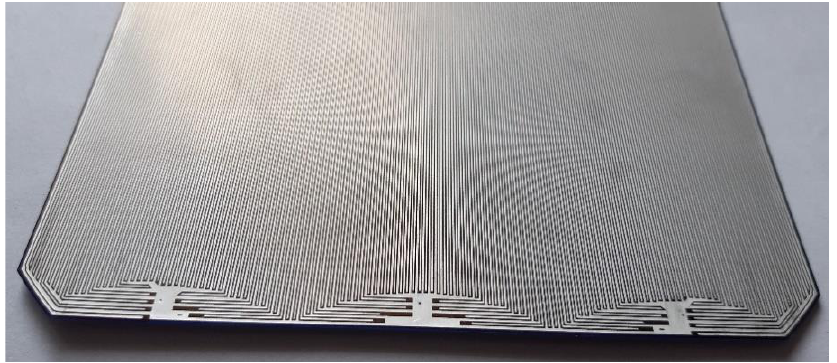
Figure 7. Rear surface of Maxeon Ne3 with visible connectors in the lower part. When analyzing the structure of the solar cell before and after the lamination process, no traces of microcracks were observed. The temperature changes during lamination and the force generated by rollers pressing the film to the solar cell did not damage the upper surface layer and the electrical connections of the solar cell. The decrease in the efficiency of the solar cell is therefore not due to microcracks, but only due to the properties of the layer of film applied during lamination. The lower efficiency and deterioration of electrical parameters are related to the light transmittance factor of the